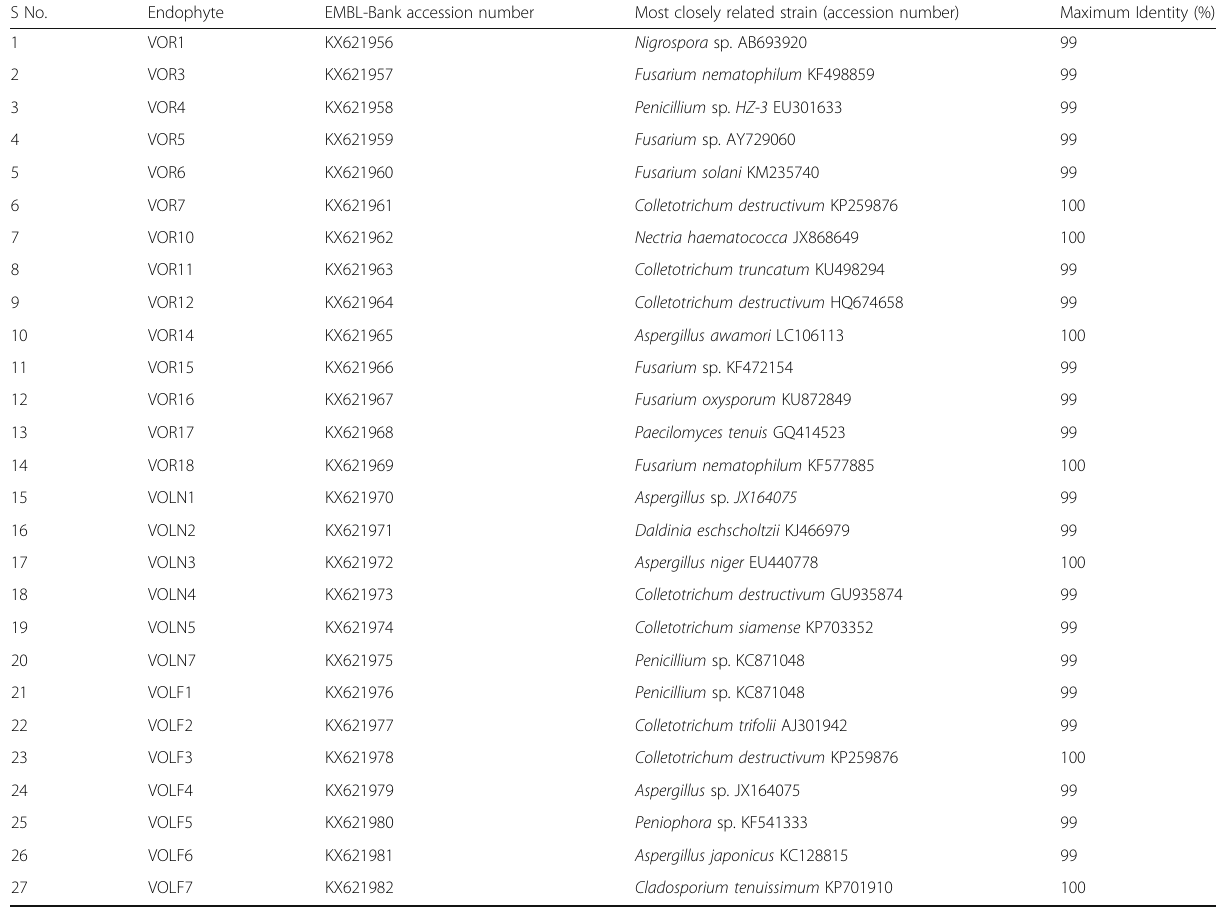
Table 1 Fungal endophytes isolated from Viola odorata